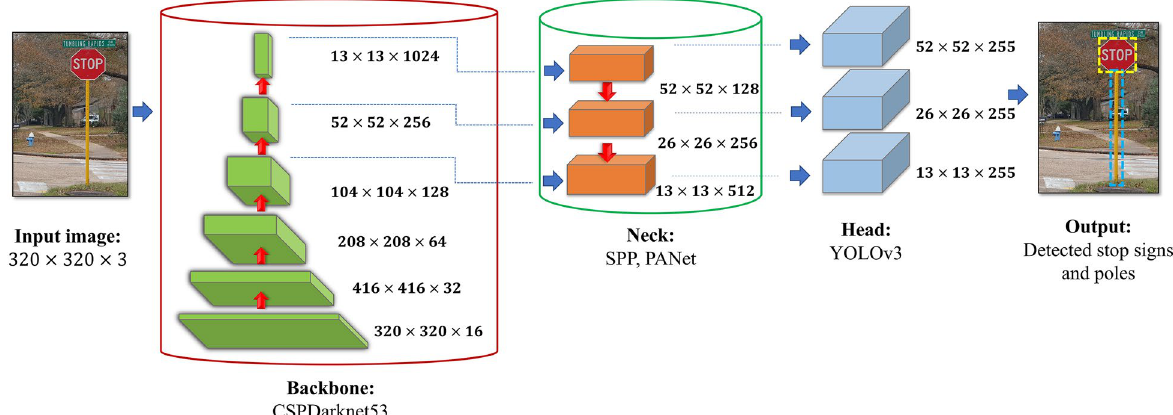
Fig. 2 The architecture of the YOLOv4 network adopted in this